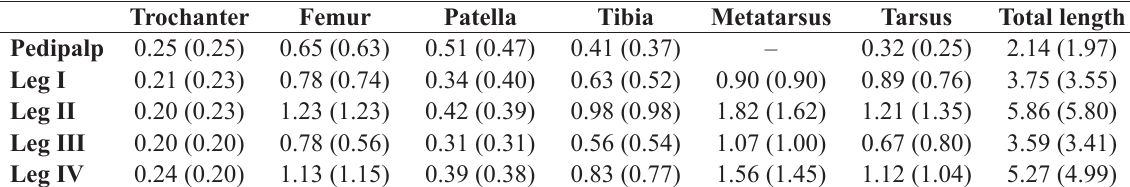
Table 5. Length of appendage-segments in millimeters in N. relictum Gruber & Martens, 1968 stat. nov. from Großes Kar, Koralpe, Austria: ♂ (♀).